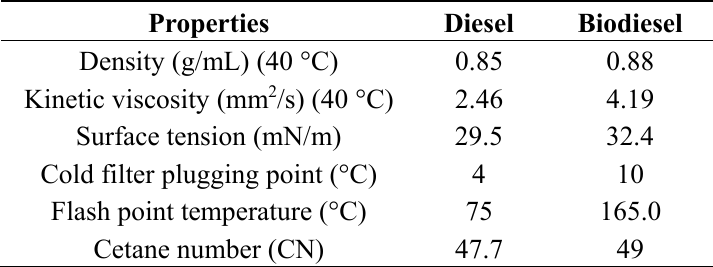
Table 1. Properties of test